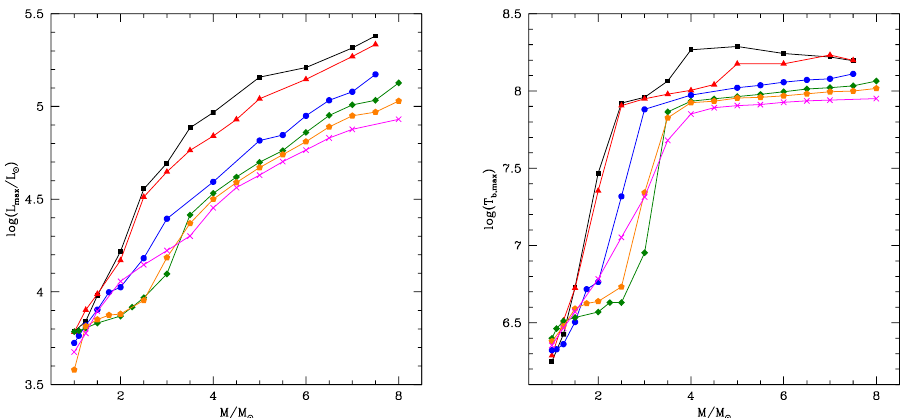
Figure 6. The largest luminosities ( left panel) and temperatures at the bottom of the envelope ( right ) attained by AGB stars, as a function of the initial mass. The various colours and symbols refer to the metallicities Z = 3 × 10 − 7 (black squares), Z = 3 × 10 − 5 (red triangles), Z = 10 − 3 (blue points), Z = 8 × 10 − 3 (green diamonds), solar metallicity ( Z = 0.014, orange pentagons), and Z = 0.03 (magenta